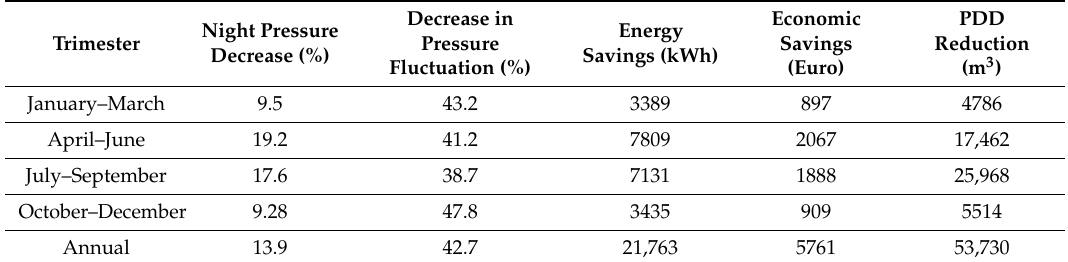
Table 6. Indicative Trimester KPIs for the performance of a theoretical pressure management (PM) scheme for 2016.